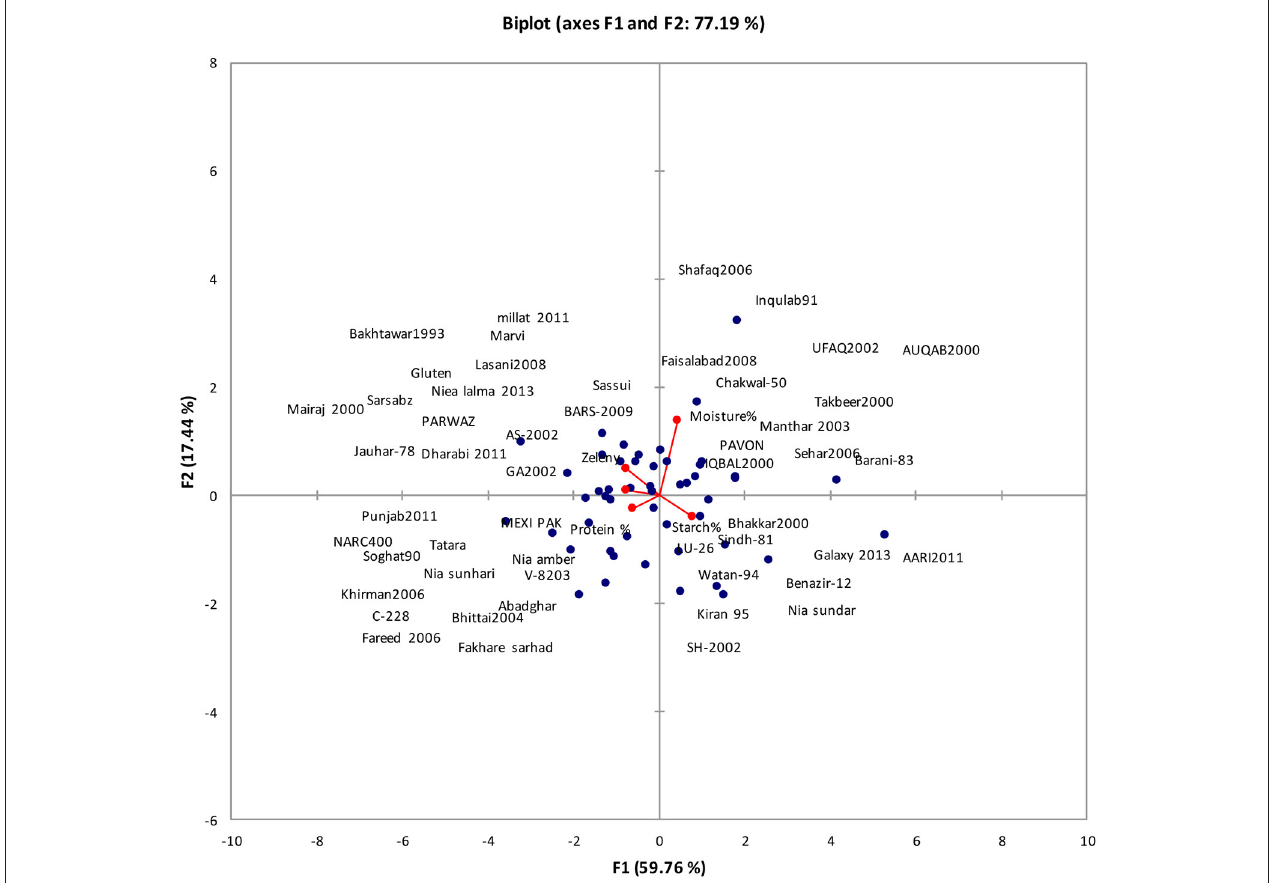
FIGURE 4 | Bi-plot of wheat genotypes for first two principal components regarding grain nutritional